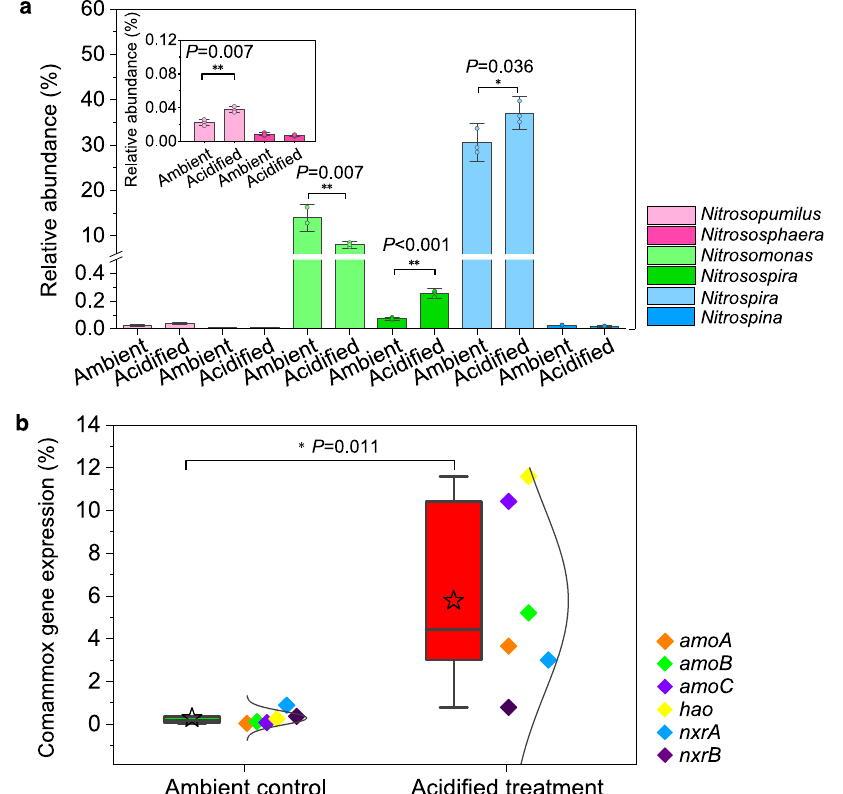
Fig. 6 | Community composition of nitrifying microbes of the enrichment cultures at the ambient control ( p CO 2 =400 μ atm; pH=8.1) and acidi fi ed treatments ( p CO 2 =800 μ atm; pH=7.8). a Relative abundance of nitrifying microbesbasedonthe16SrRNAgenesequencingwithuniversalprimerscapableof detecting both bacteria and archaea within the same sequencing libraries. The inserted plot shows the relative abundance of ammonia-oxidizing archaea ( Nitro- sopumilus and Nitrososphaera ). Single asterisk denotes signi fi cant difference at P <0.05, while double asterisk denotes signi fi cant difference at P <0.01. Error bar represents SD ( n =3 biologically independent samples), and dots are